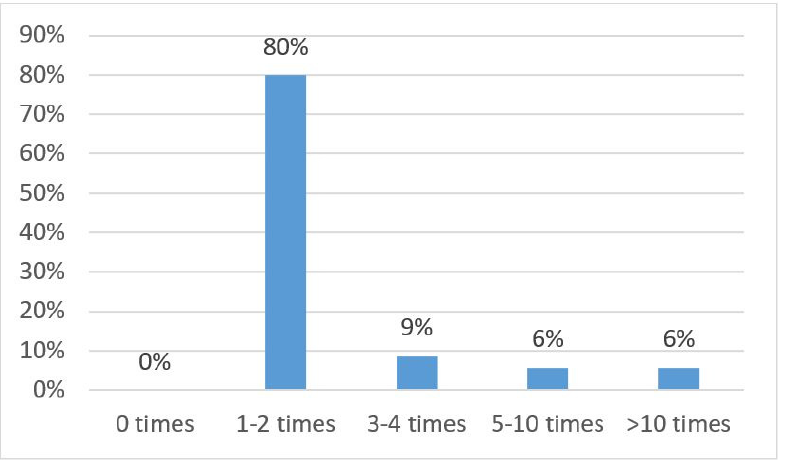
Figure 3. Frequency of use of the VHF radiotelephone.